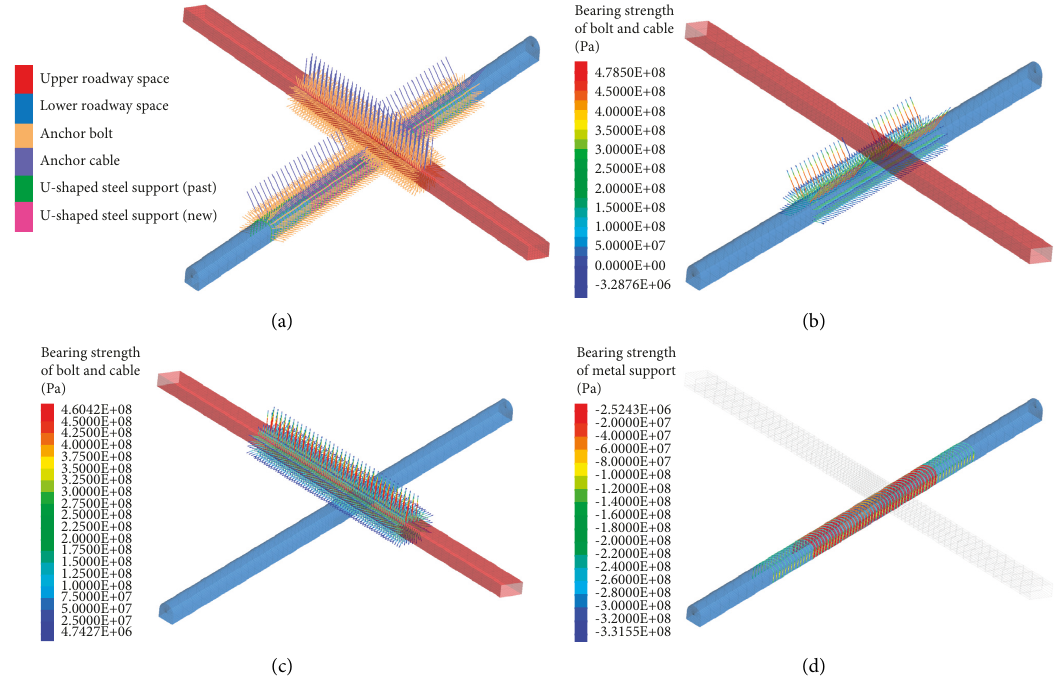
Figure 17: Stress characteristics of supporting structures in the staggered roadways position. (a) Roadway support layout model, (b) bearing condition of bolt and anchor cable active support structures in lower roadway, (c) bearing condition of bolt and anchor cable active support structure in upper roadway, and (d) bearing condition of U-shaped steel support in lower